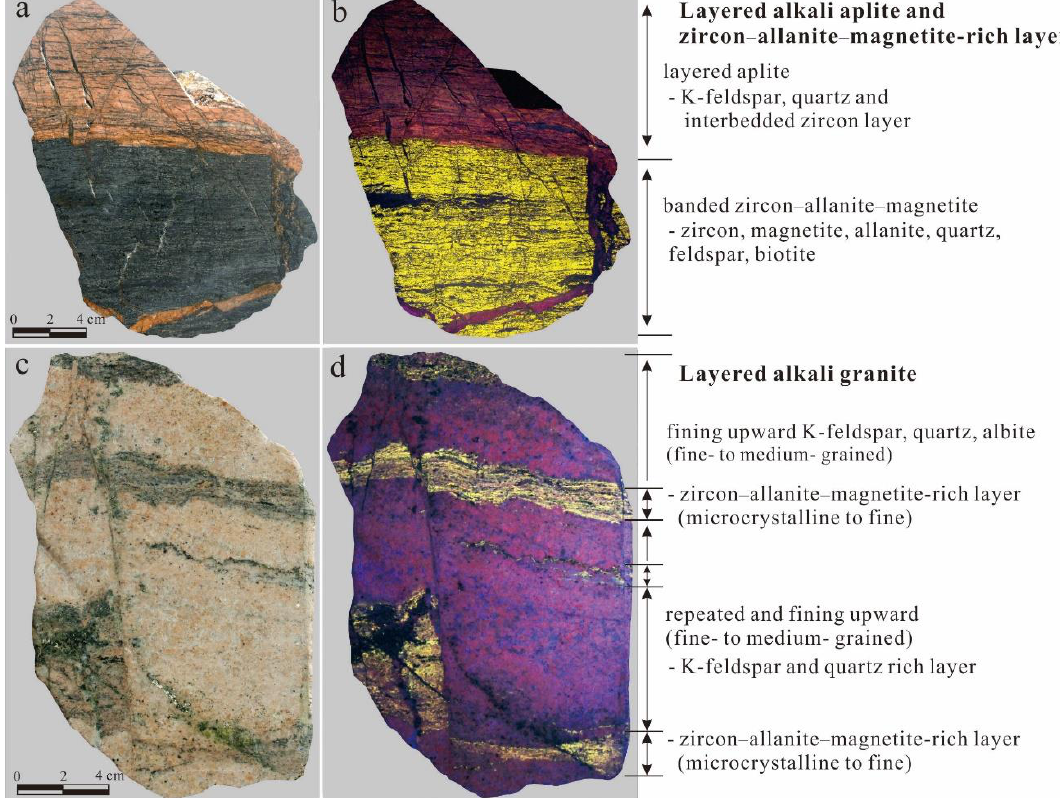
Figure 3. Representative Zr–Nb–Y–rare earth element (REE)-enriched alkali rocks from the Chungju deposit. ( a ) Sharp contact between a zircon–allanite–magnetite-rich layer and layered alkali aplite. ( b ) Sample in ( a ) under UV illumination. The yellow emission is attributed to uranium activation [23]. ( c ) Layered alkali granite showing repeated grain-size grading in quartz–feldspar-rich layers and zircon–allanite–magnetite-rich layers. ( d ) Sample in (c) under UV illumination. Under UV radiation (254 nm), zircon shows a distinctive yellow fluorescence color.